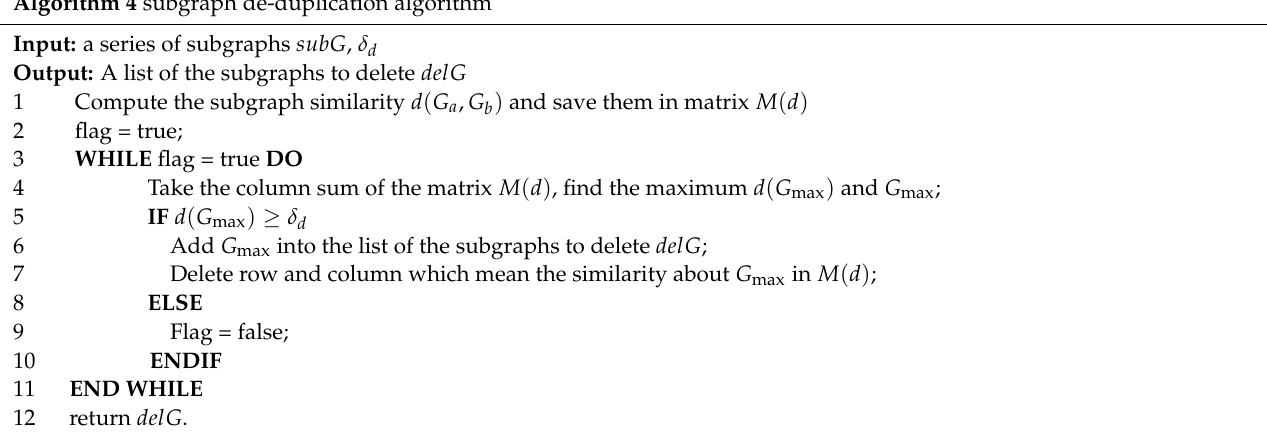
Algorithm 4 subgraph de-duplication